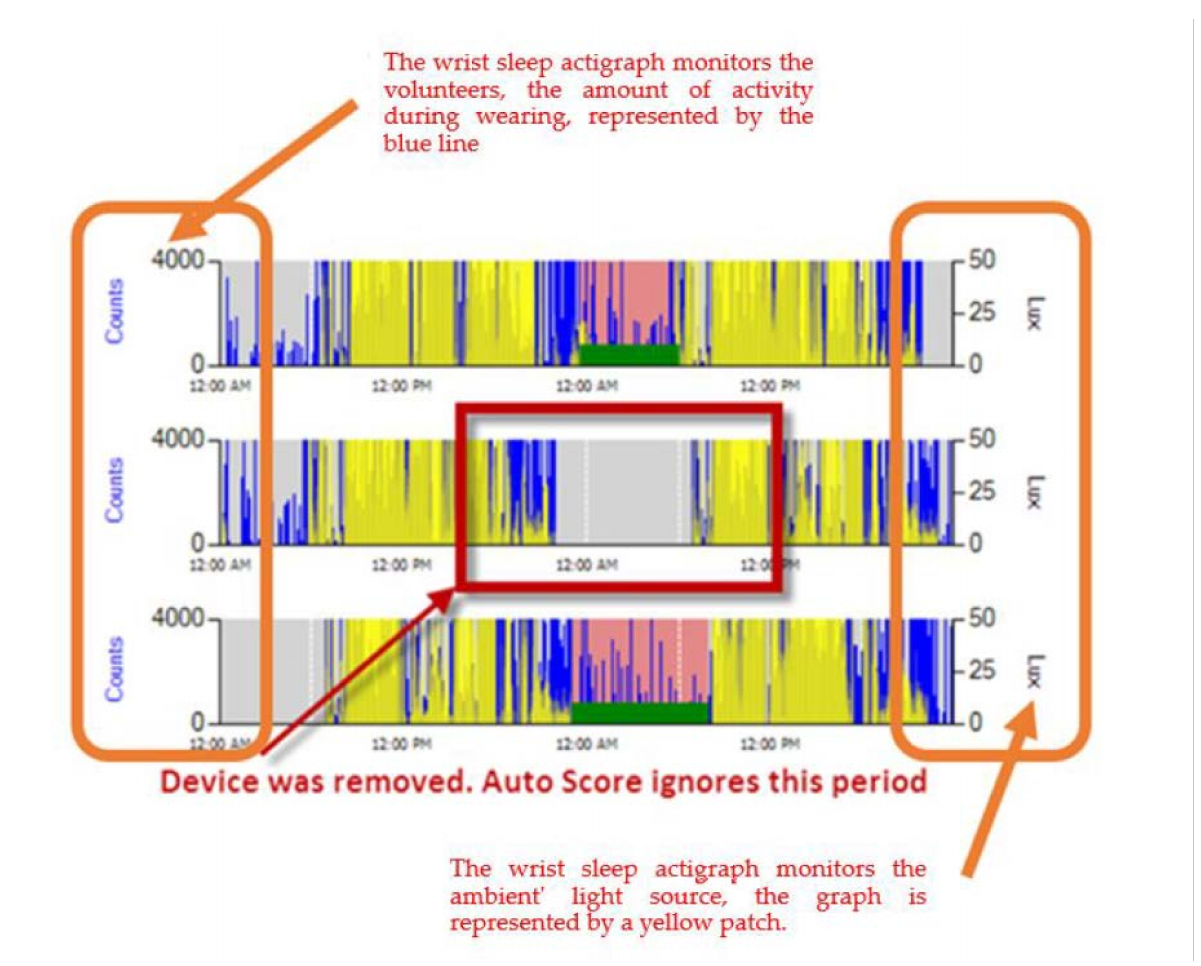
Figure 7. After a long period of demonstration, the software directly shows that the wrist sleep actigraph has not captured the volunteers data at all.